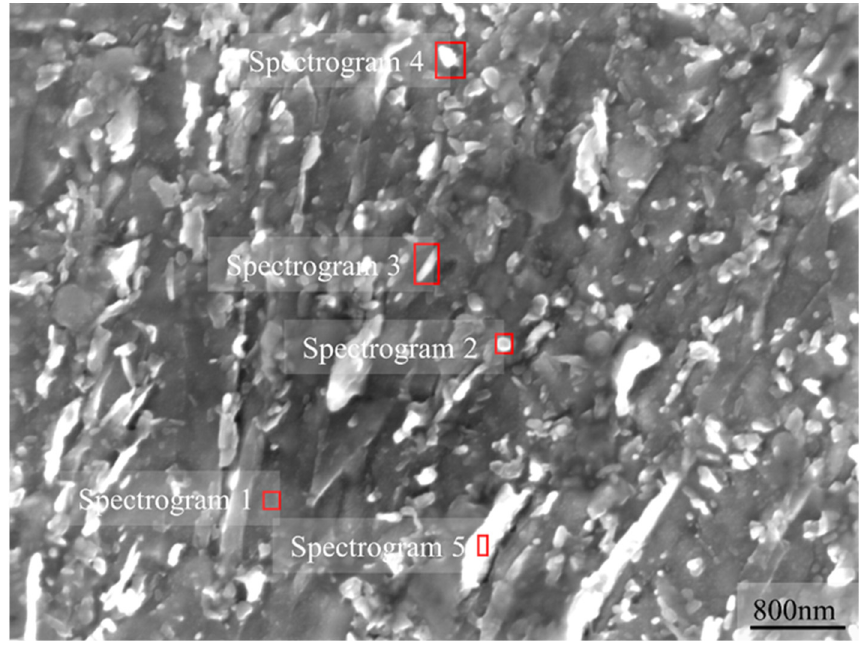
Figure 11. EDS spectrum test electron chart. Table 2. Composition of precipitates (at %).